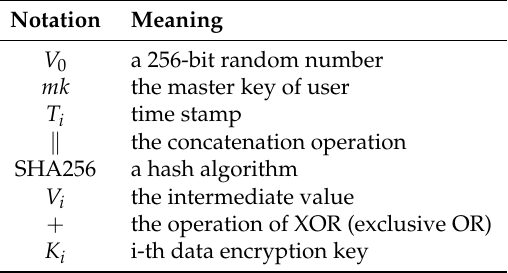
Figure 2. The Data Encryption Keys Generation Algorithm. Table 1. The list of notations in Figure